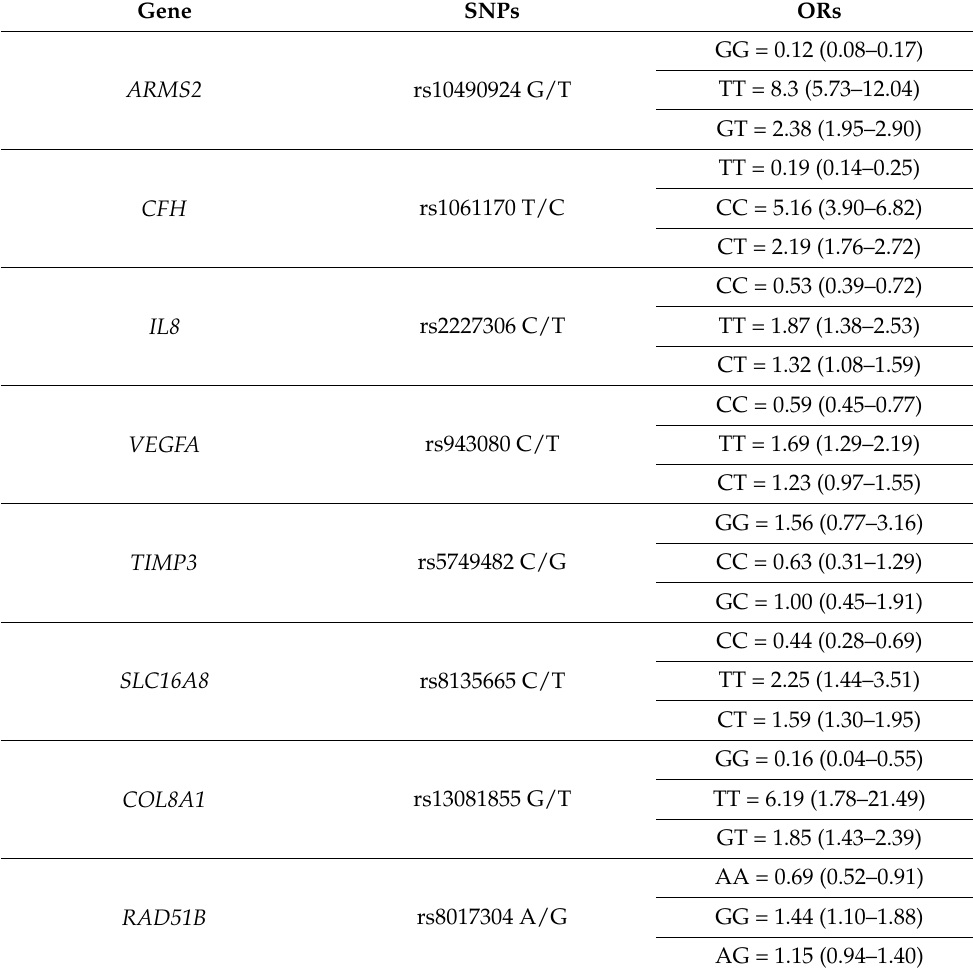
Table 1. Genetic risk variants and their normalized ORs employed by WARE.